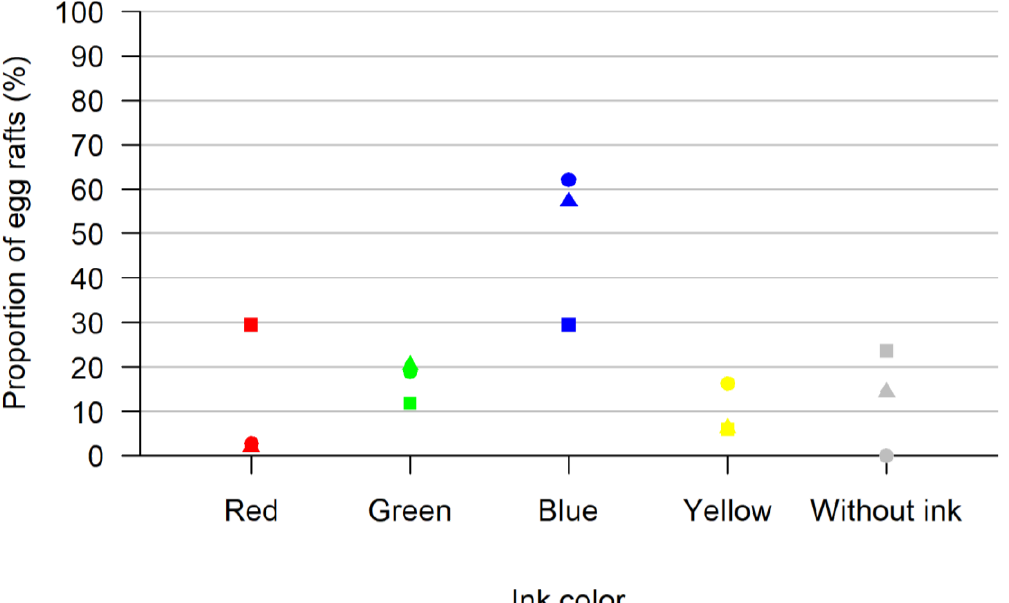
Figure 1. Results of the test for acceptance of ink solution as an oviposition option. Shown are the proportions of egg rafts laid in each colored oviposition site (red, green, blue, yellow and without ink) for all three replicates in percent. In each replicate, all colors were offered at once. Each replica is represented by a different form (square, triangle, circle).